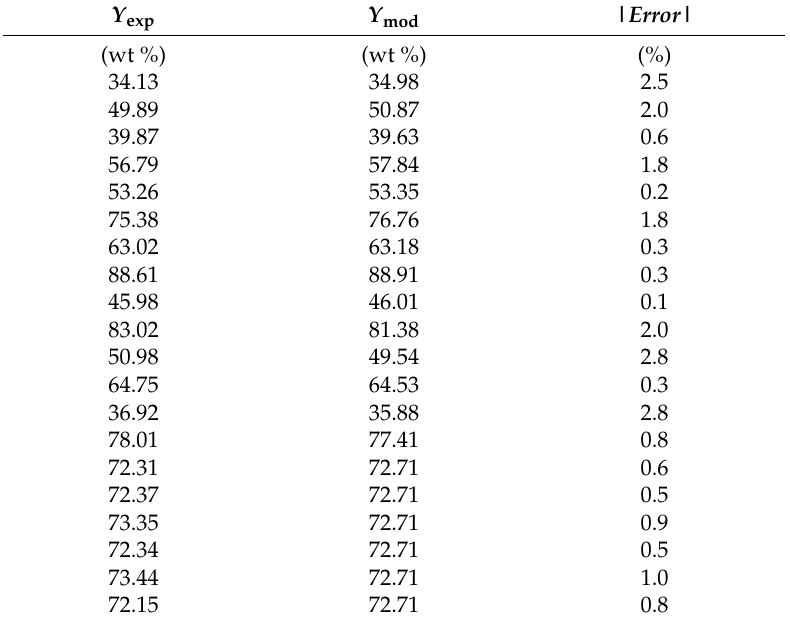
Table 5. Comparison between experimental and modeled Fatty Methyl Ester (FAME) yield. Y exp Y